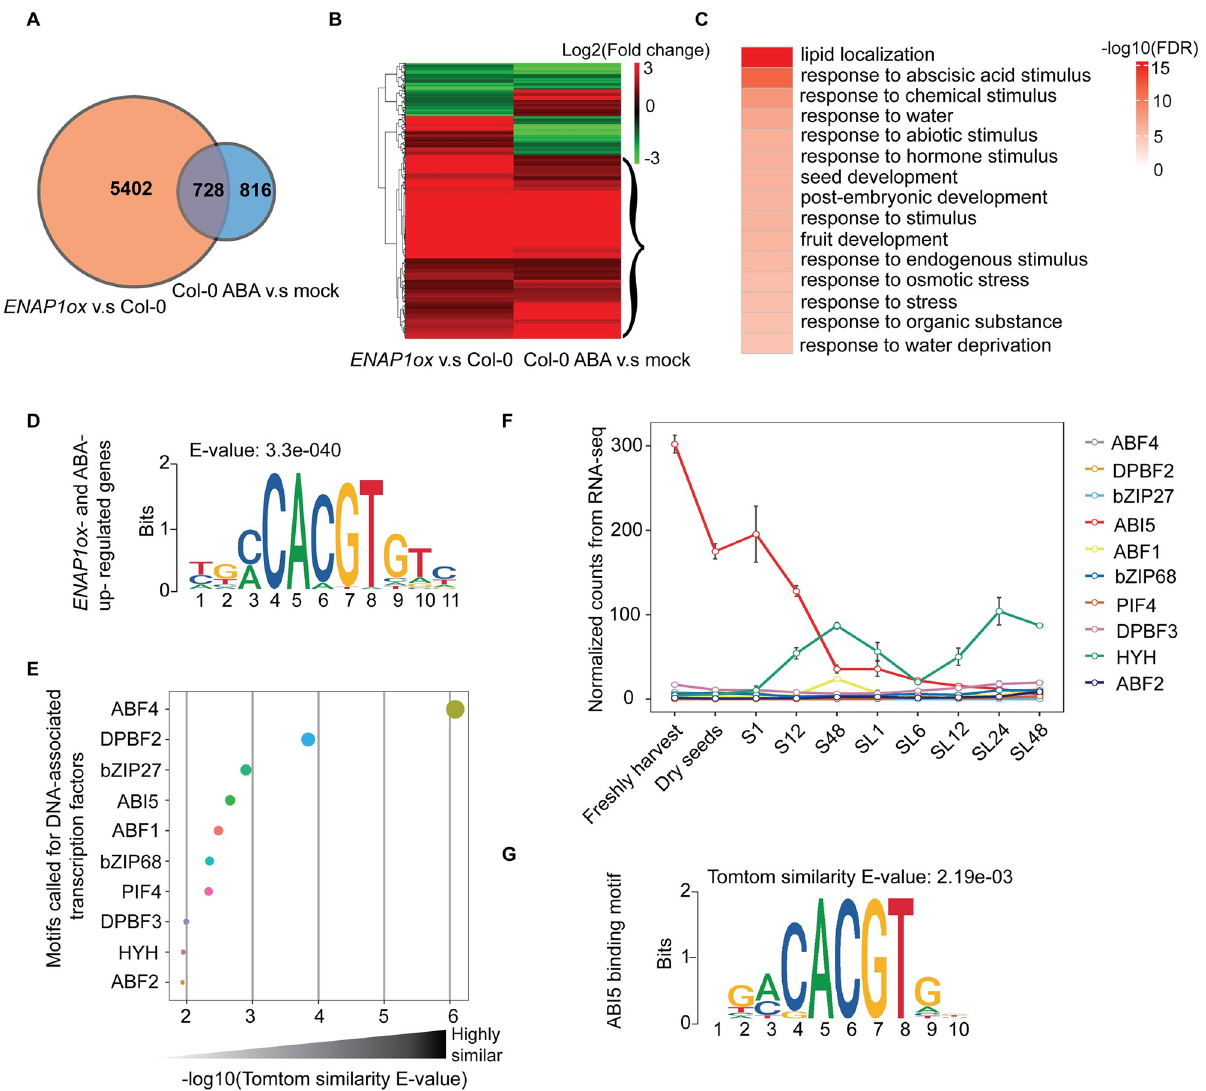
Fig 2. ENAP1 is involved in the regulation of ABA-responsive genes. ( A ) Venn diagram showing the number of genes regulated by ABA and ENAP1. ( B ) Heatmap to show the correlation of genes differentially regulated by ABA and ENAP1. Curly bracket indicates genes both up- regulated by ABA and ENAP1 (totally 485 genes). ( C ) Gene Ontology analysis of the genes that are both up- regulated by ABA and ENAP1. ( D ) DNA motif that was identified from 1k bp upstream of TSS in ABA and ENAP1 up- regulated genes. ( E ) The motif in ( D ) was compared to all plant motifs in CIS-BP2.0 database with Tomtom motif comparison tool [54], and top 10 motifs were selected. TFs associated with those motifs were plotted according to similarity scores (-log10(E-value)). ( F ) Expression levels of top 10 TFs during seed germination. Raw counts from published RNA-seq data [39] were normalized to the TPM (Transcripts Per Million). Samples were from freshly harvested and dry seeds, and seeds following indicated time of stratification (S) and post-stratification (SL). Each data point represents mean ± s.d. of three replicates. ( G ) ABI5 binding motif from CIS-BP2.0 database. Tomtom E-value indicates the similarity between ABI5 binding motif and YGMCACGTGTC motif.